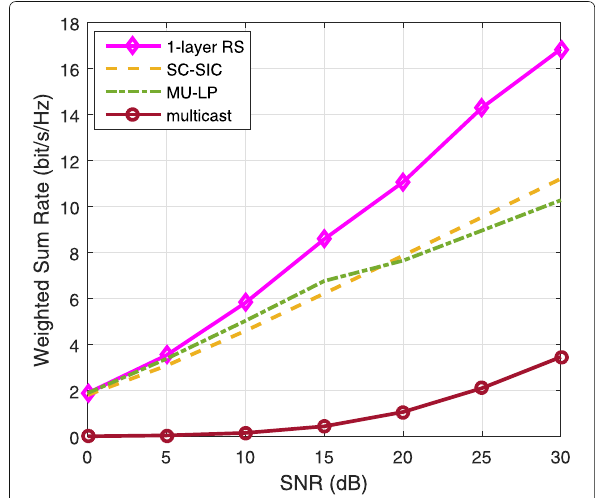
= [0,0.001,0.004, th